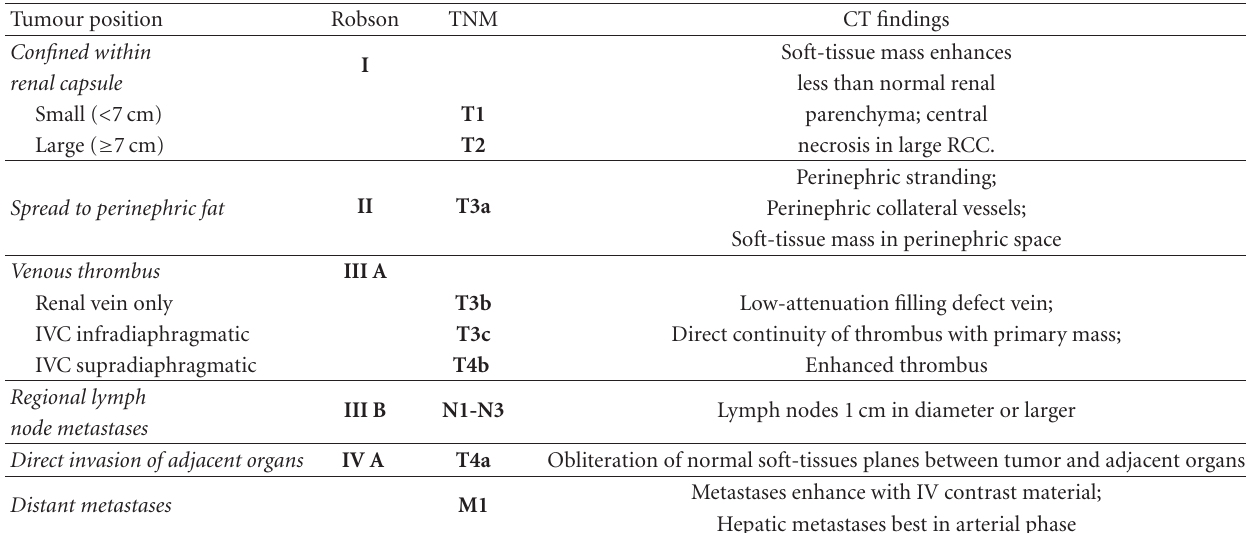
Table 1: Staging system for renal carcinoma and CT